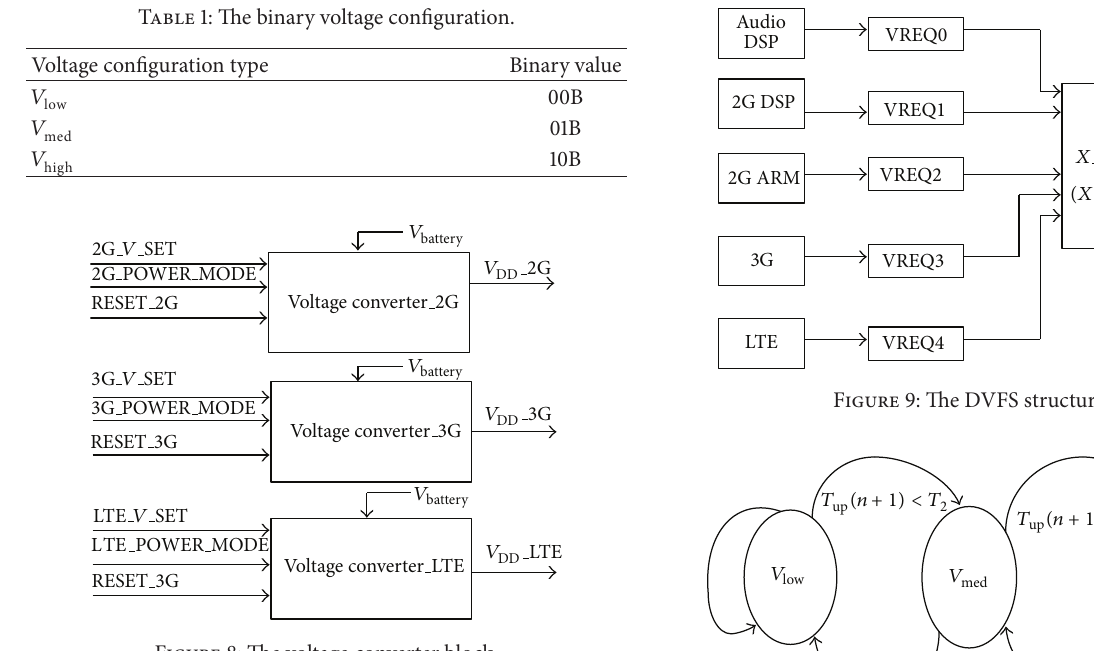
Figure 8: The voltage converter block.